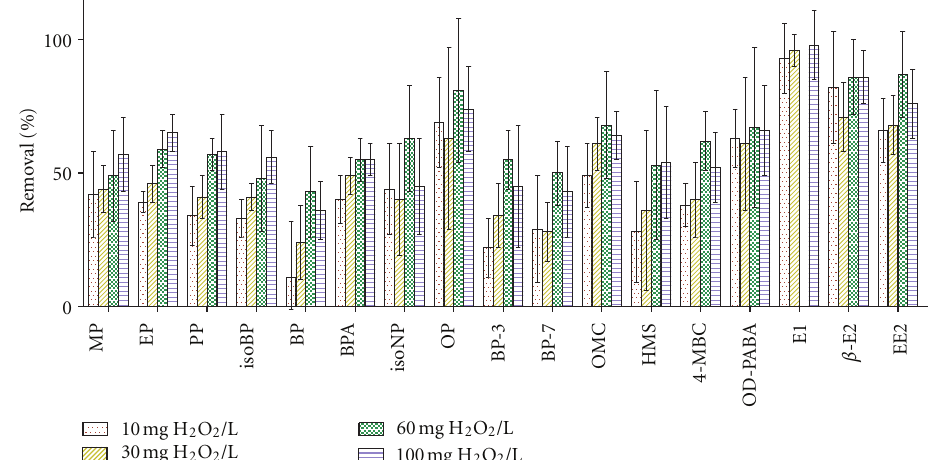
Figure 3: The removal of estrogens in wastewater e ffl uent at varying concentrations of hydrogen peroxide at constant energy dose (1.8kWh/m 3 ). The error bars present the 95% confidence